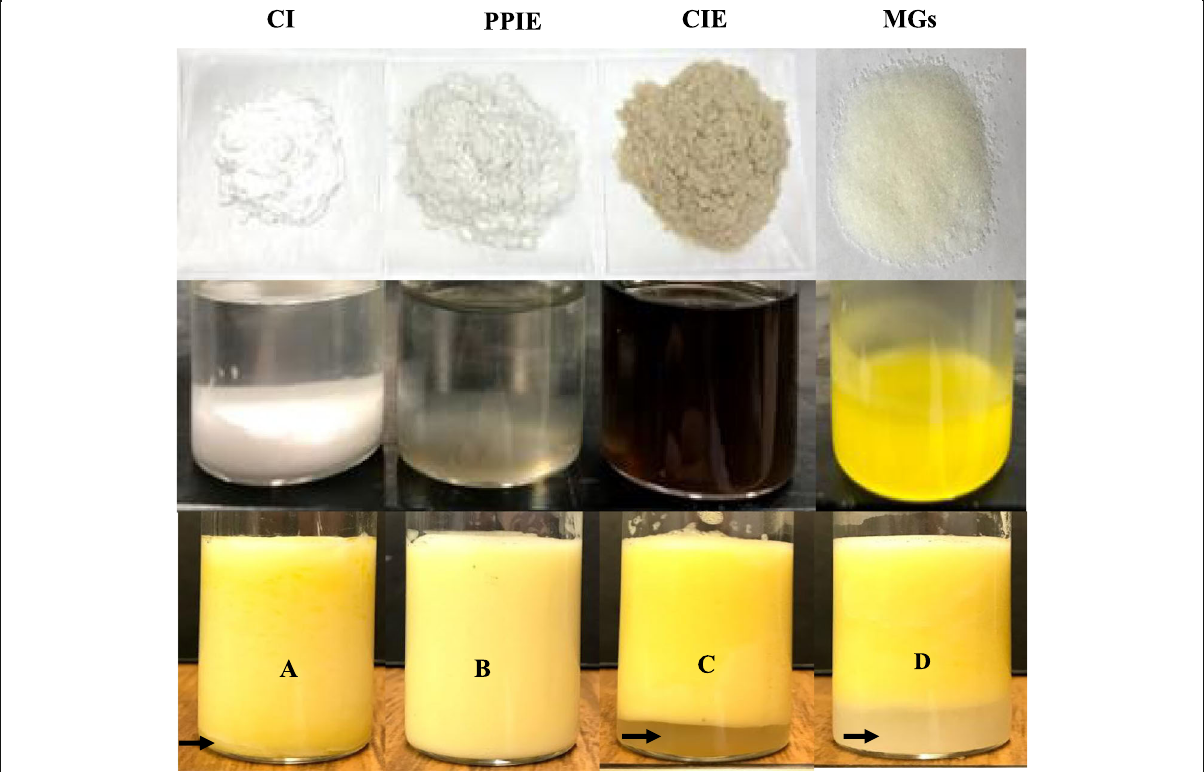
Fig. 3 The powders, gels and emulsion gels formed by inulin and/or MGs. The first row from the top shows the pictures of CI (commercial inulin from chicory root), PPIE (primary purified inulin extract from JA), CIE (crude inulin extract from JA) and MGs (monoglycerides) powders; The middle row shows the pictures of gels formed by corresponding powders solution through the heating-cooling process. The bottom row shows the pictures of emulsion gels; a contains CI; b contains PPIE; c contains CIE; d is control (no inulin). Black arrow shows separations in emulsion